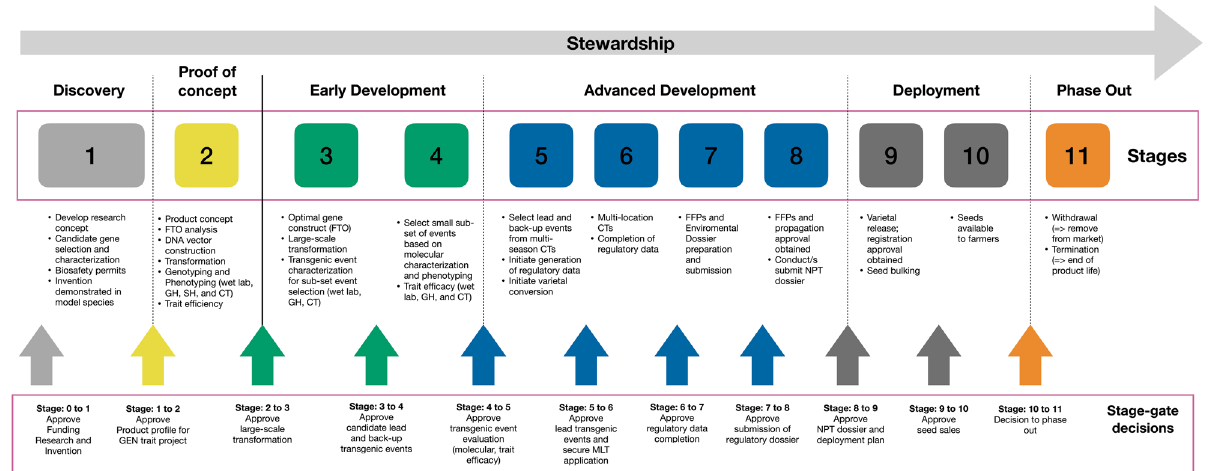
Figure 1. The life cycle of a transgenic product development. A stepwise process that involves several stages for transgenic product development. Advancement from one stage to the next is determined by thorough data analysis and fulfillment of certain criteria, specific for each stage. CT: Confined test on the field; FFP: food, feed, and processing; FTO: freedom to operate; GEN: Genetic engineering; GH; greenhouse; MLT: multi-location CT; NPT: national performance trial; SH: